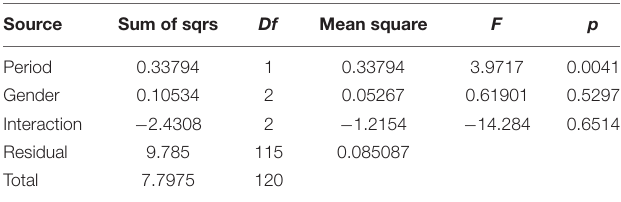
TABLE 4 | Results [i.e., proportion (%) of correct answers] from Q1 and Q2.